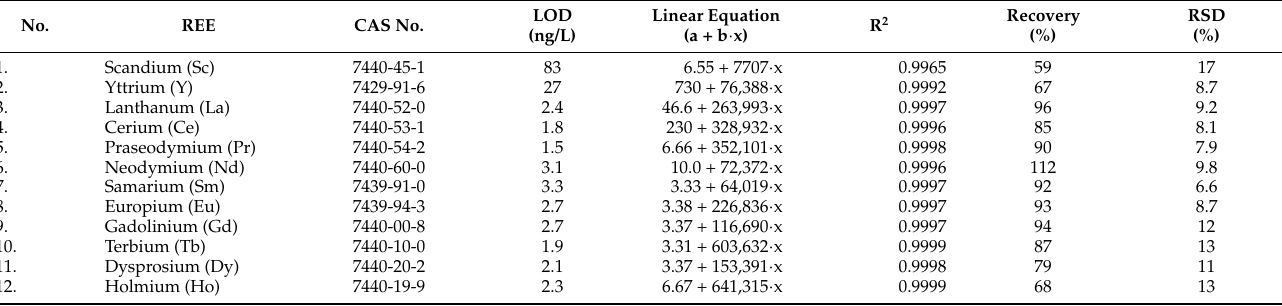
Table 3. Analytical characteristics of DSPME-ICP-MS of